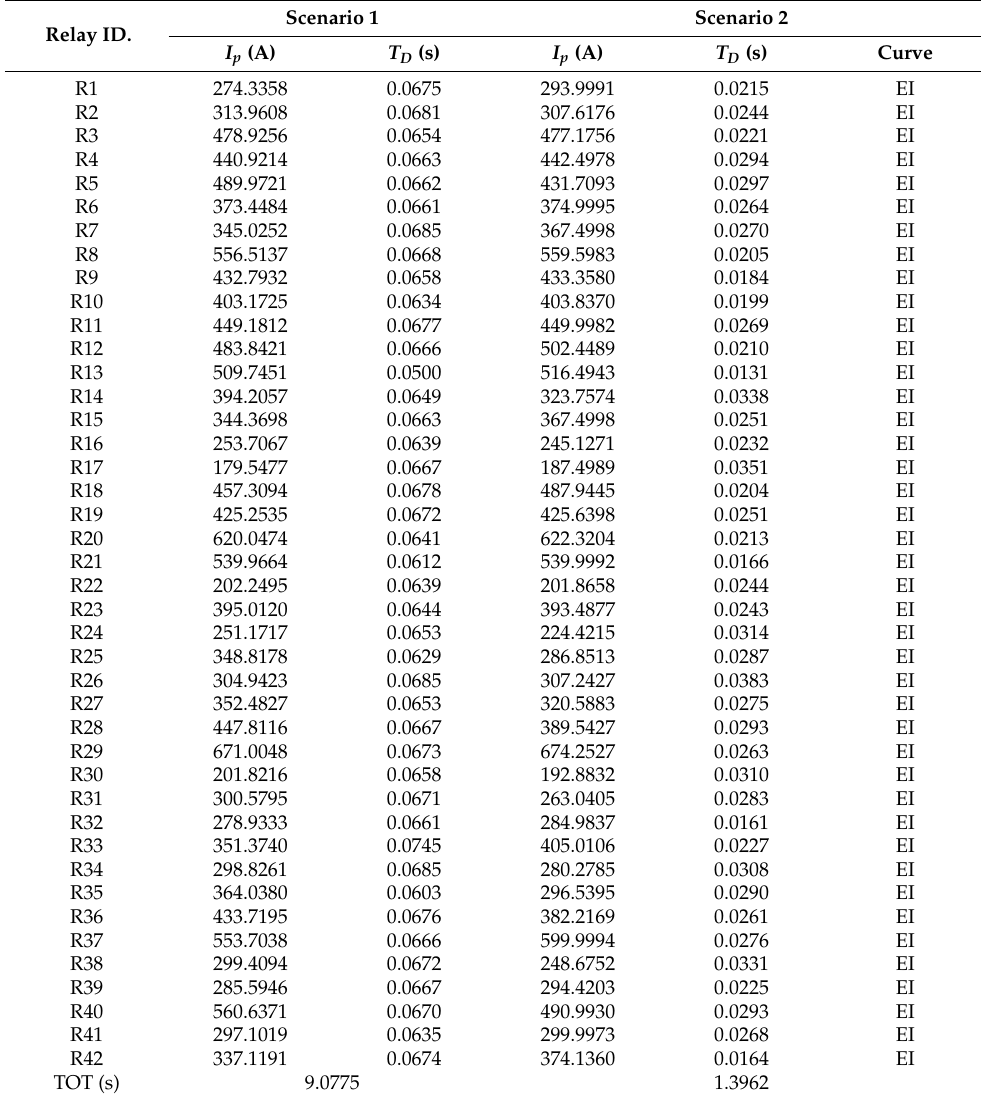
Table 2. Optimum DOCRs settings of the IEEE 15-bus using GTO. Relay